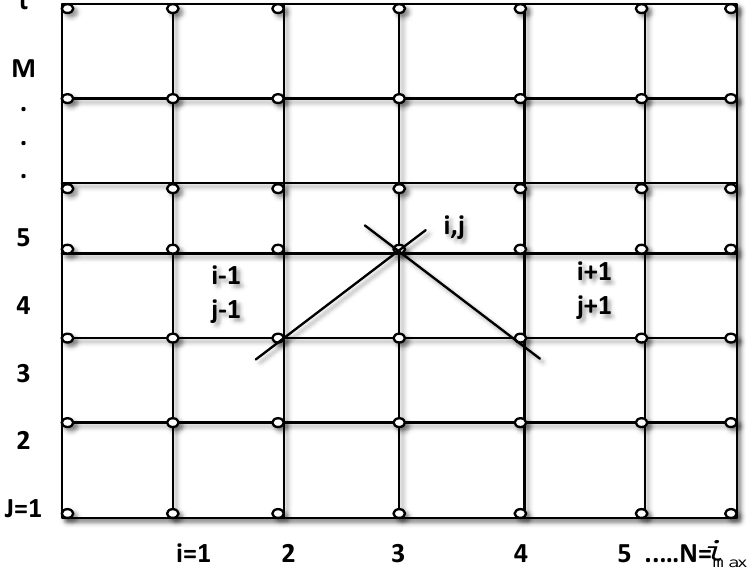
Figure 16. Computational mesh grid with an index for MOC.